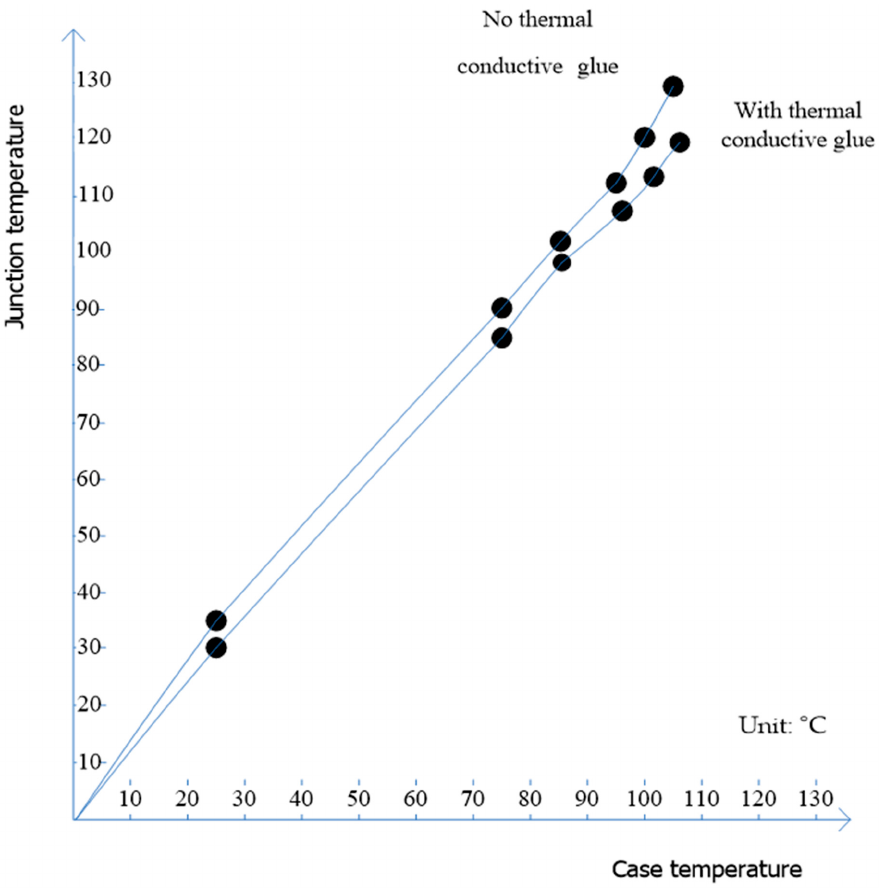
Figure 8. Comparison of heat dissipation before and after SiP chip’s